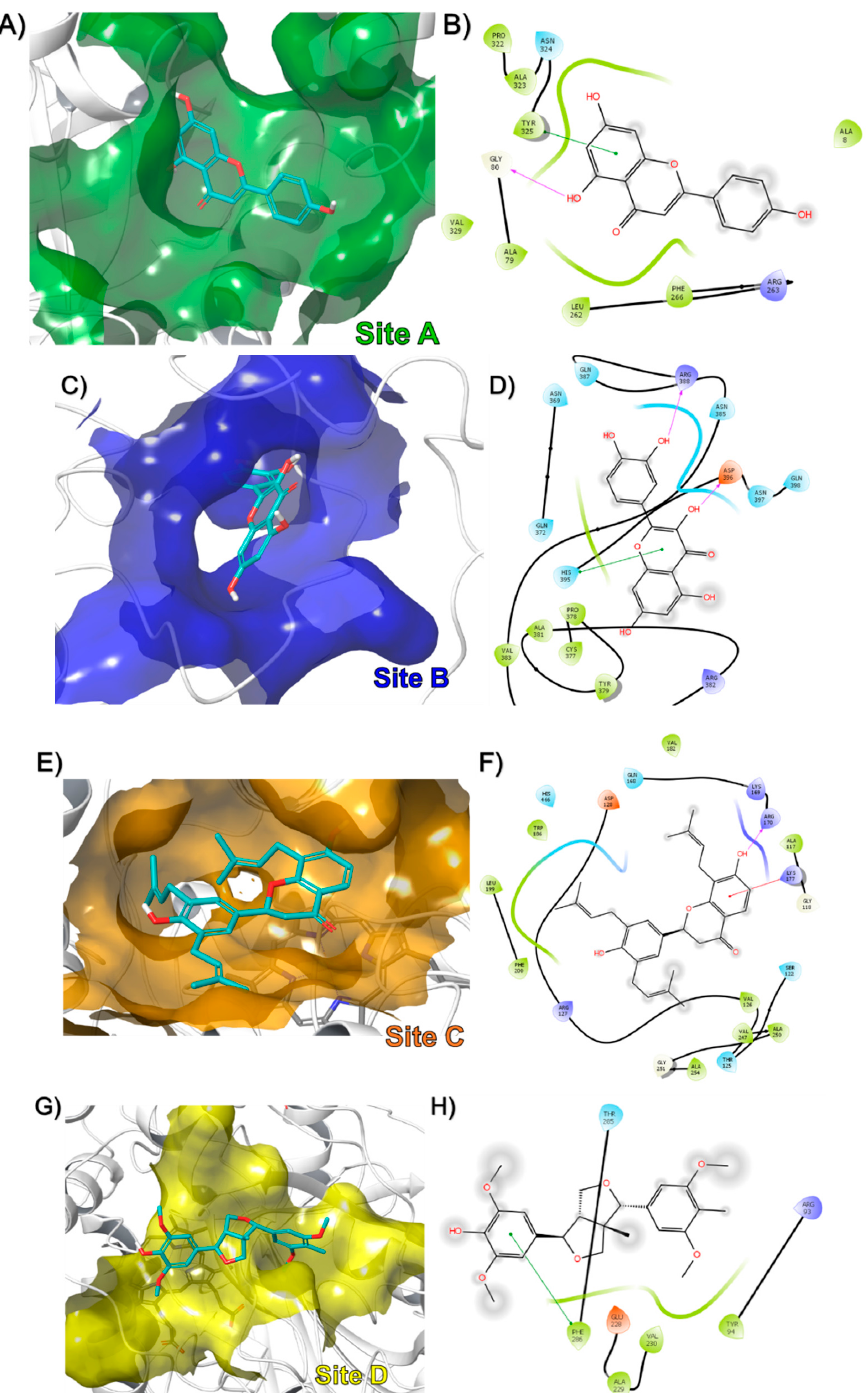
Figure 5. Binding mode of compound ( A ) 15, ( C ) 16, ( E ) 4, and ( G ) 43 in rat liver catalase monomer, as well as 2D interaction map for ( B ) 15, ( D ) 16, ( F ) 4, and ( H )